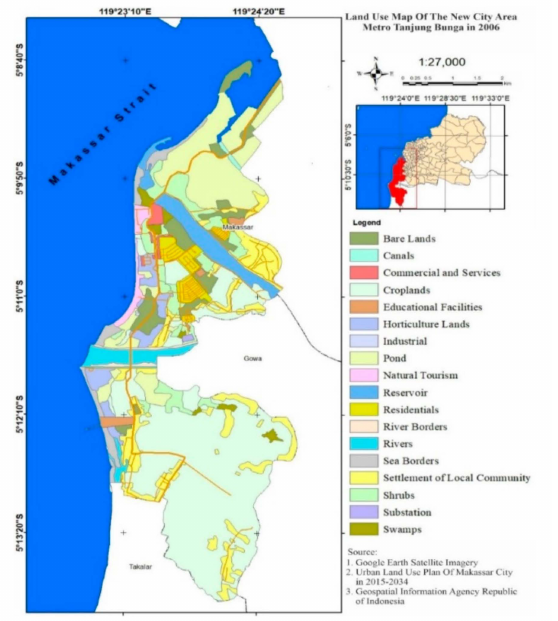
Figure 5. Utilization of the new city area of Metro Tanjung Bunga, Makassar City in 2006–2008. Source: Author